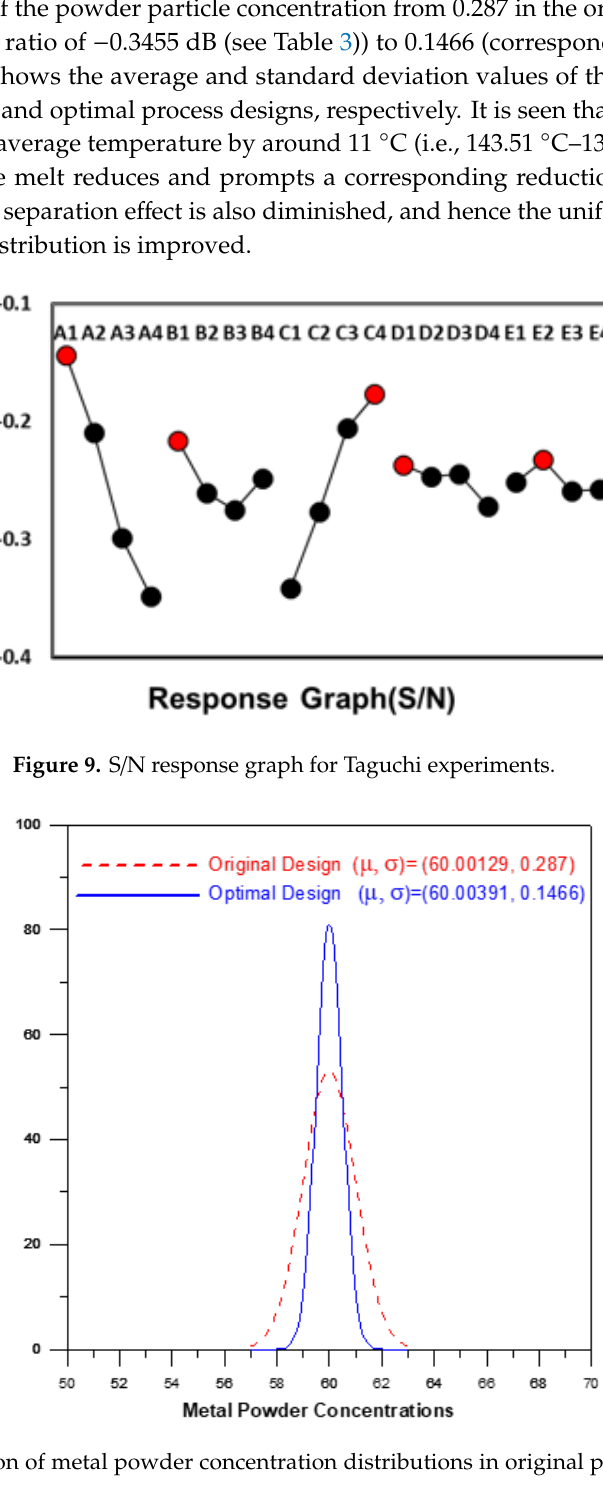
Figure 10. Comparison of metal powder concentration distributions in original process design and optimal process design.